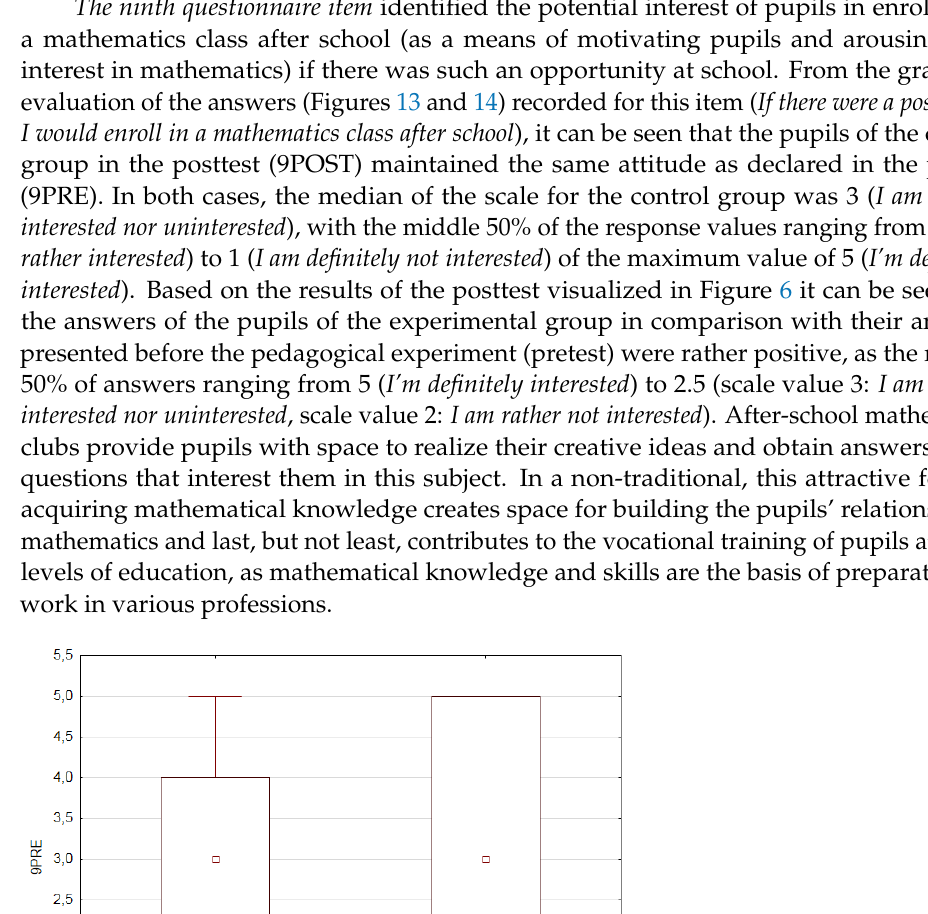
Figure 11. The box graph of the fourth item of the pretest - 4PRE.